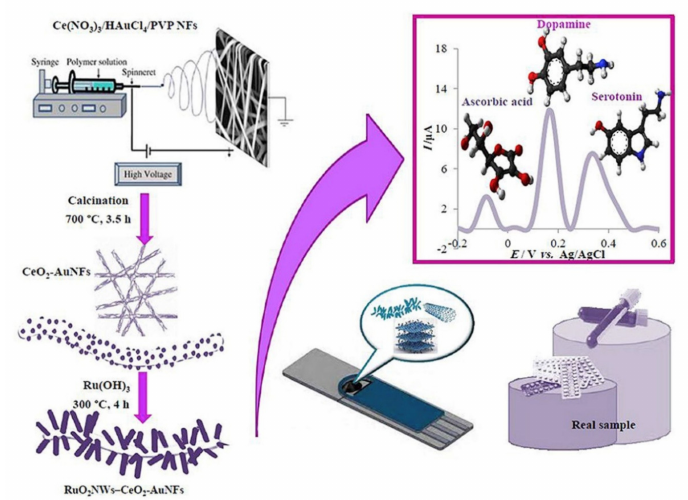
Figure 9. Scheme of the fabrication process and the detection mechanism of a sensor based on RuO 2 NWs, CeO 2 , Au nanofibers (Au NFs), GO and functionalized multi-walled carbon nanotubes (f-MWCNTs) towards serotonin. Reprinted from [120] with permission of